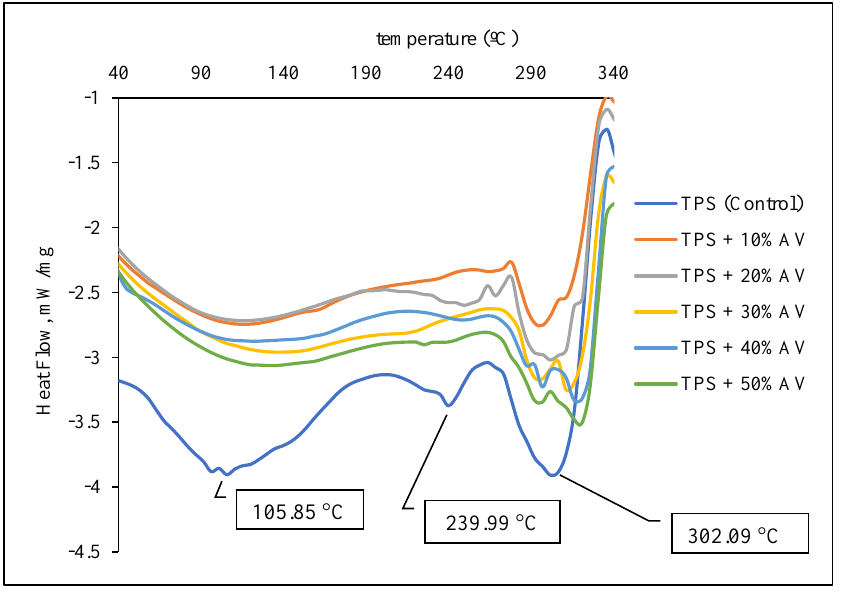
Figure 4. DSC of TPS film with different AV gel concentrations.